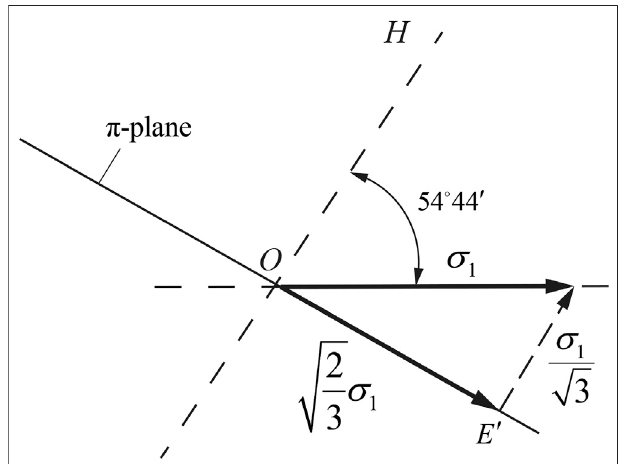
FIGURE 3 | The locus of σ 1 on the π -plane.